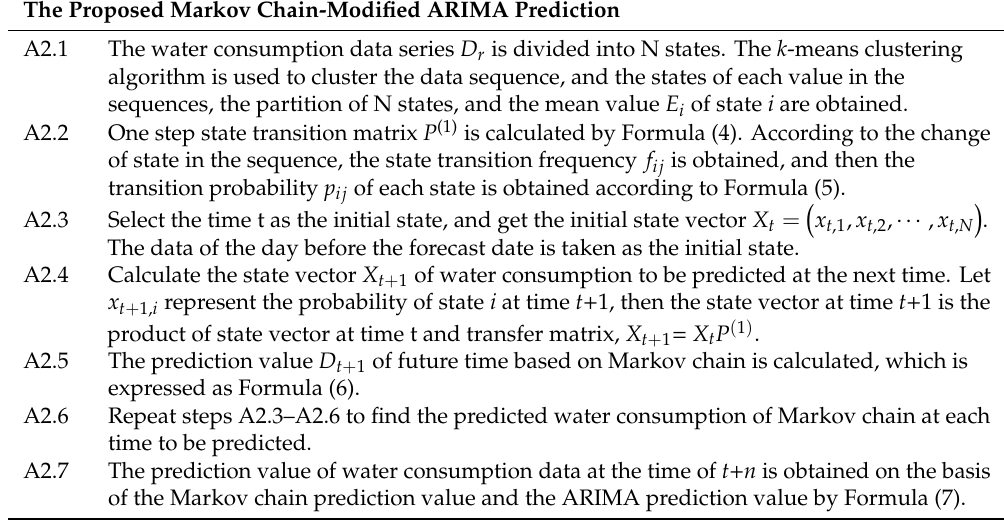
The Proposed Markov Chain-Modified ARIMA